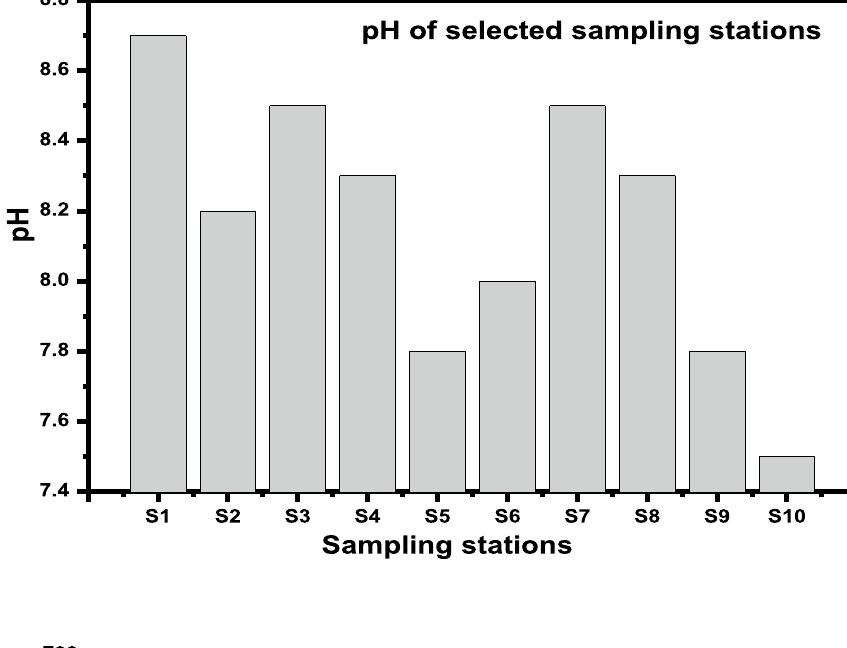
Fig. 3 TS of selected